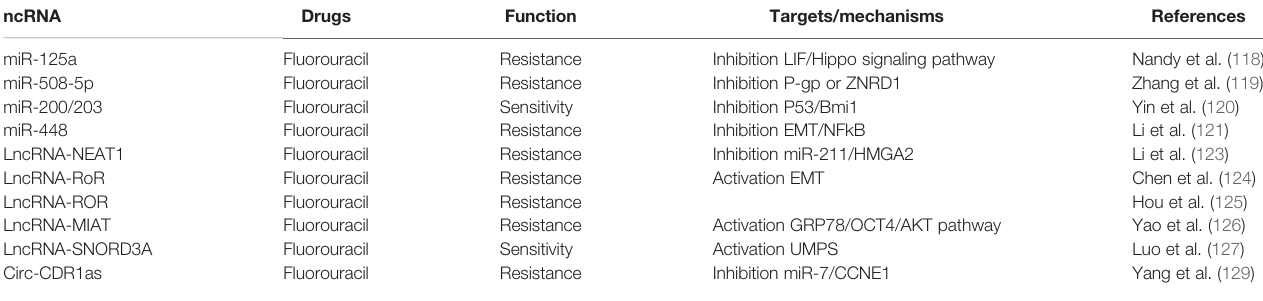
TABLE 5 | Breast cancer fl uorouracil chemoresistance related ncRNAs.